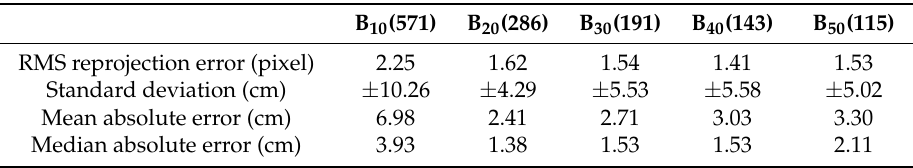
Table 3. Statistic results of the accuracy assessment of the Pavilion with variable baselines. In the brackets of the first line are the number of